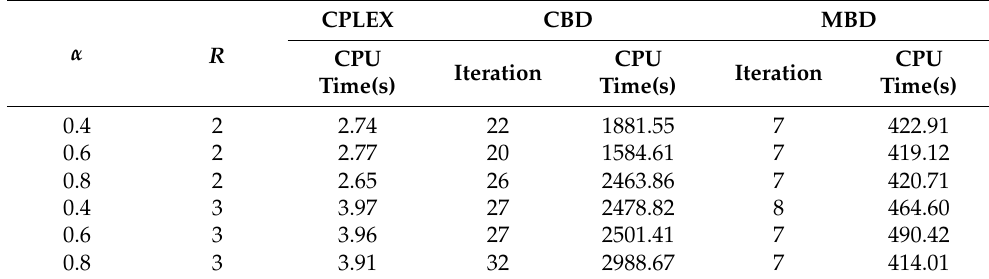
Table 1. Computational results of different